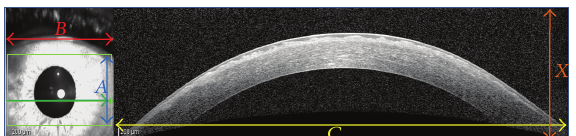
Figure 16: The method to calculate the number of pixels for